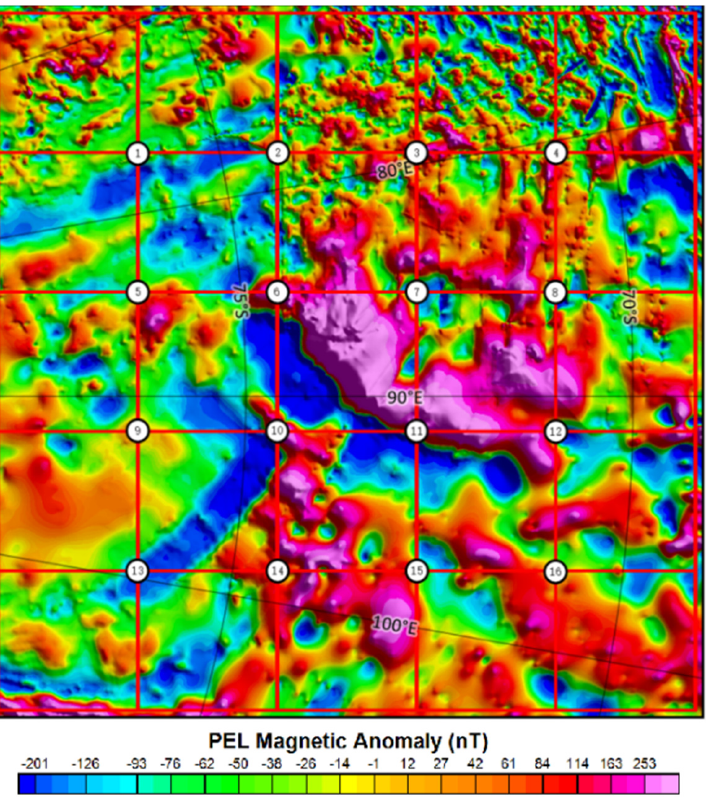
Figure 3. Princess Elizabeth Land block divisions for calculation. Taking the marked position (white circle) as the center, the size of each window is 400 × 400 km, and the adjacent windows have a 50% overlapping coverage rate. There are 16 square windows in total covering PEL.